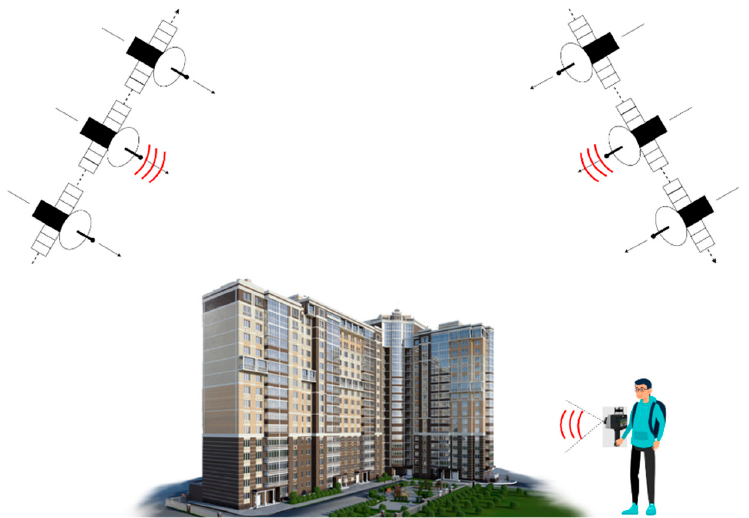
Figure 1. Schematic map of multi-view urban building point cloud acquisition (tomographic synthetic aperture radar system and backpack mobile 3D laser scanner).